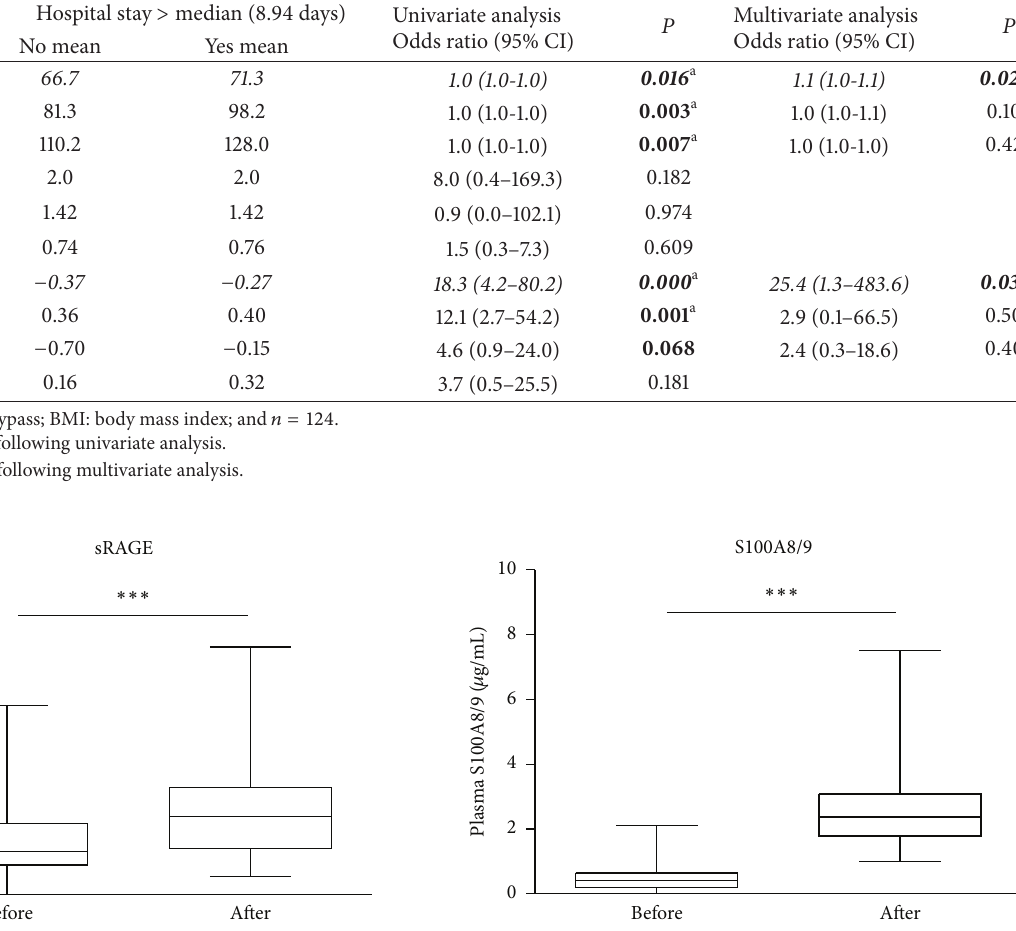
Figure 2: Plasma levels of S100A8/9 increased 2 h after surgery necessitating cardiopulmonary bypass compared with preoperative levels. Data presented as bar graphs with median and 75th